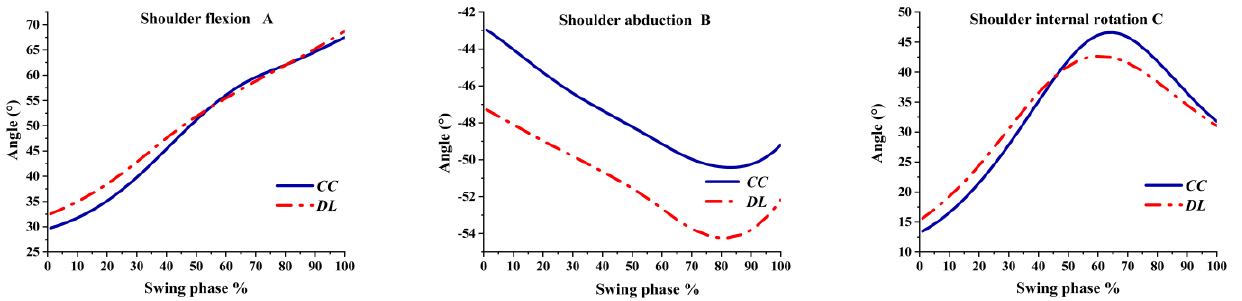
Figure 5. The shoulder angles during the swing phase. The thorax–pelvis angles in the sagittal plane, the coronal plane and the transverse plane were extension, right lateral flexion and internal rotation, respectively. The extension and right lateral flexion angle continually decreased from the beginning of the swing phase. Different from DL, the right lateral flexion in the CC decreased sharply at 70%, as shown